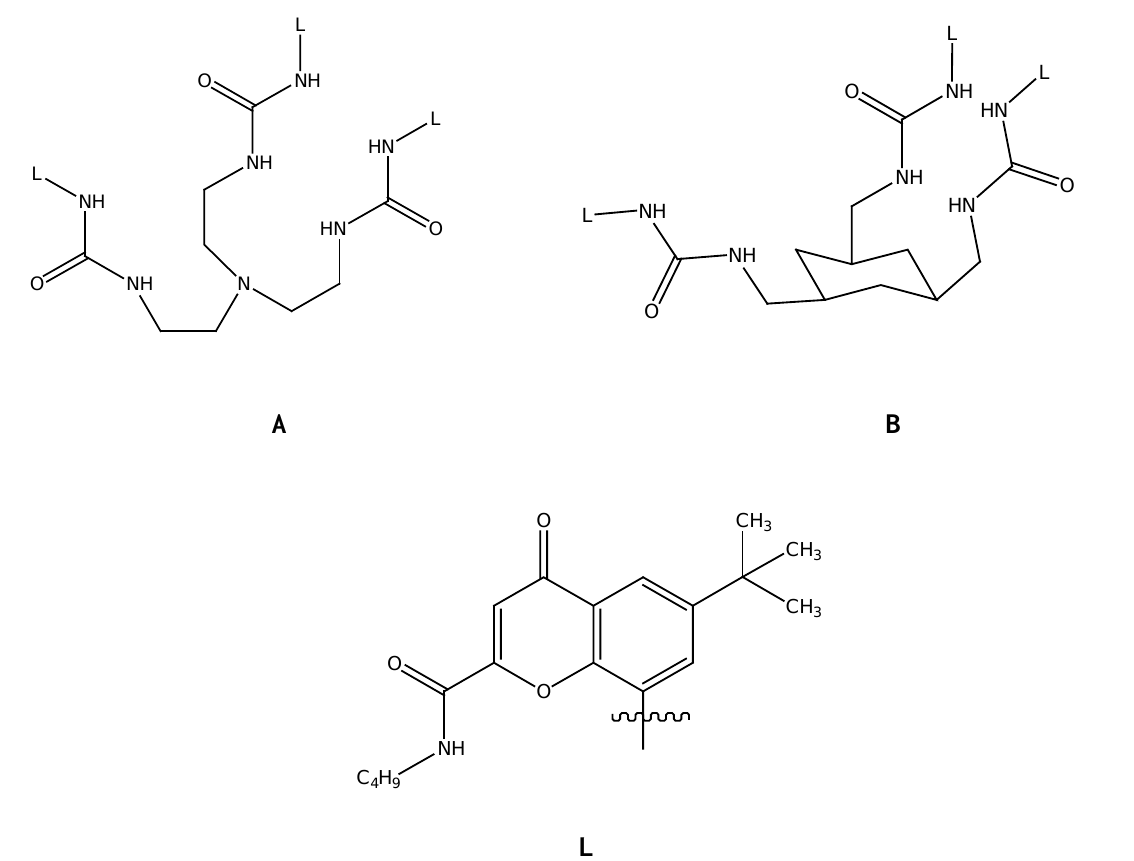
Figure 45. Tris(2-aminoethylamine) (A) and cis -1,3,5tris(aminomethyl) cyclohexane